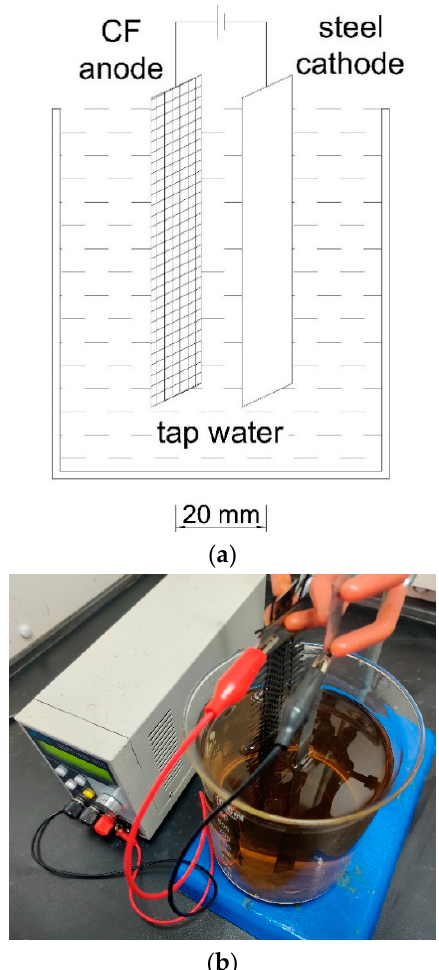
Figure 1. Schematic view ( a ) and photograph ( b ) of the electrochemical system to prepare oxide/grapheme